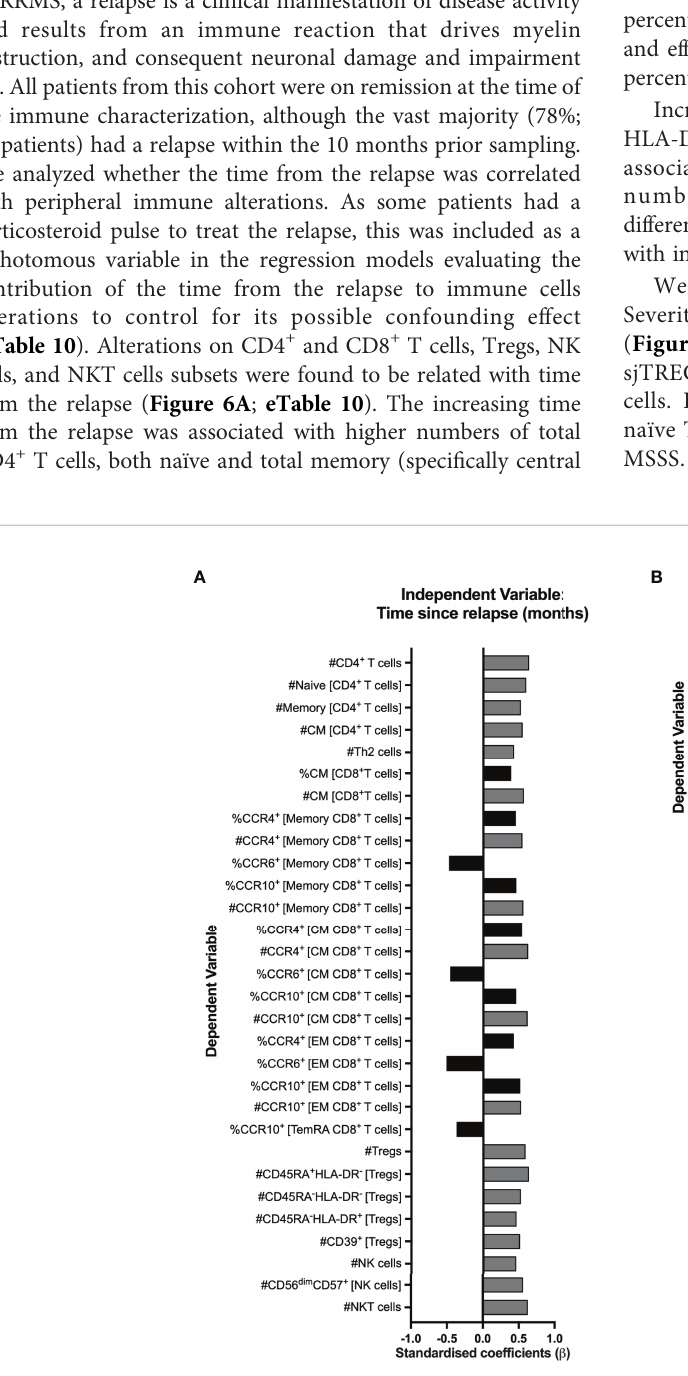
FIGURE 6 | Time from the exclude relapse and MS severity score (MSSS) relates to immune system cell alterations in RRMS patients. Represented are the standardized coef fi cients ( b ) from multiple or linear regression models having as exclude independent variable the time from the exclude relapse (A) or the MSSS (B) , respectively. The dependent variable consisted of the unstandardized residuals from a preliminary multiple linear regression where the contribution of sex, age, and anti-HCMV IgG seroprevalence on the blood populations was evaluated (as described in the Materials and Methods section). Only the blood populations for which the linear regression models were signi fi cant ( p < 0.050) for the variable of interest are represented. Statistical outputs and effect size calculations are represented in eTables 10, 11